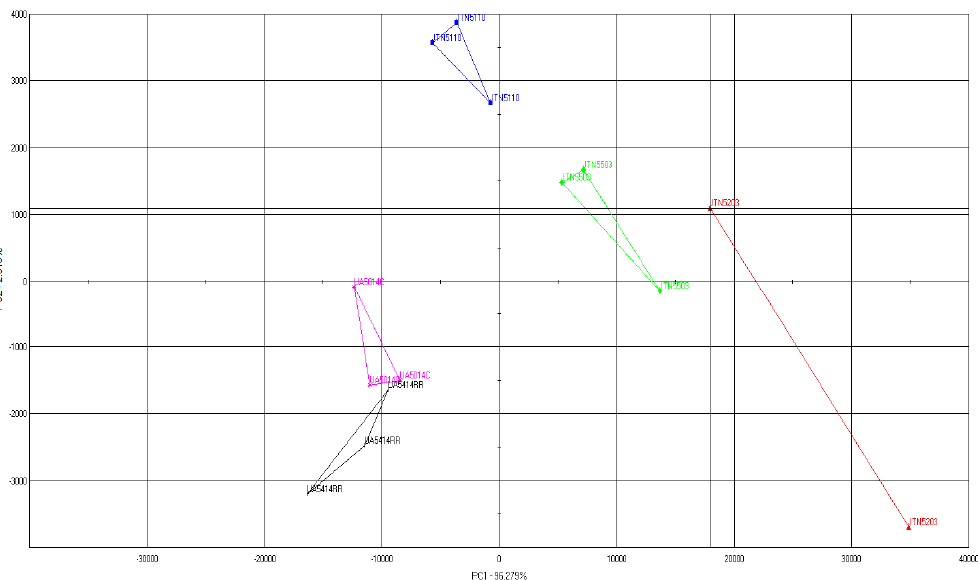
Figure 1. PCA plot of volatile profiles from soybean cultivars.